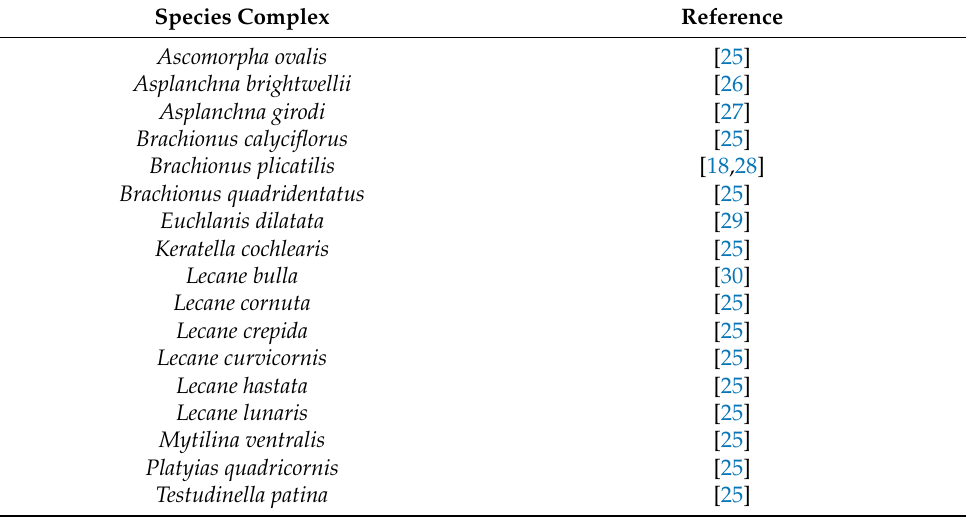
Table 2. Some species complexes and cryptic species of rotifers reported from Mexico.